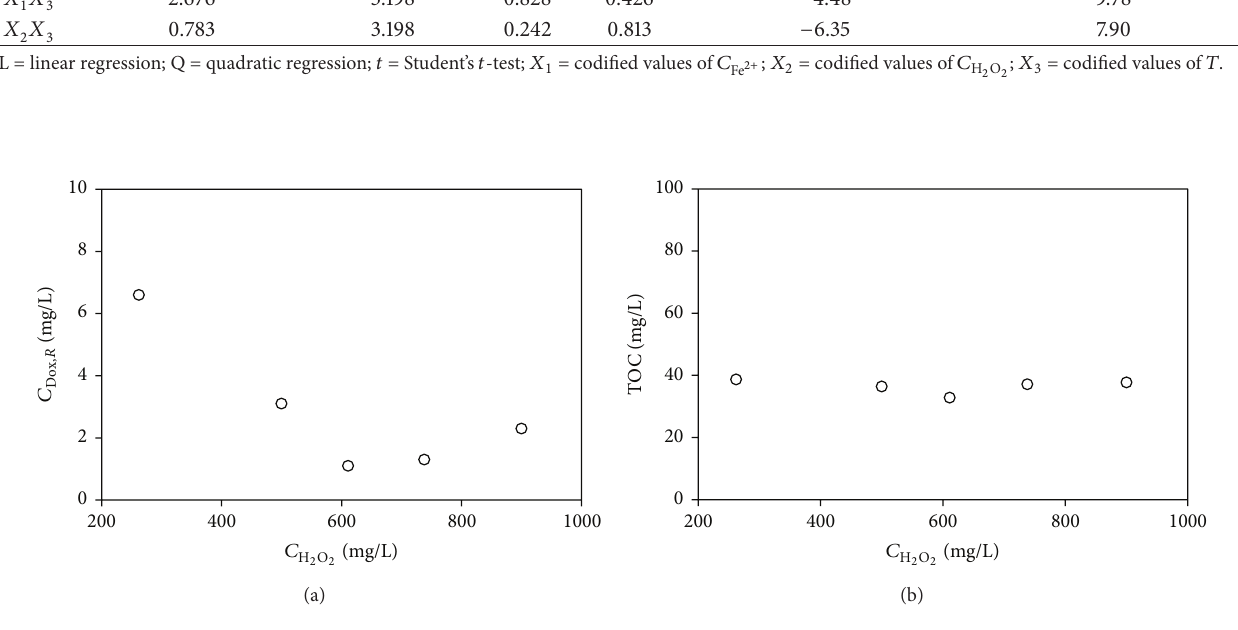
) on residual concentrations of (a) doxycycline ( 𝐶 H 2 O 2